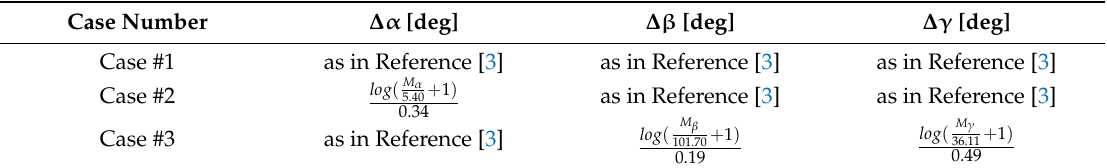
Table 1. The target angular displacements under the moment loads (“as in reference [3]” refers to the displacements based on an actual verified model of the IJ presented in